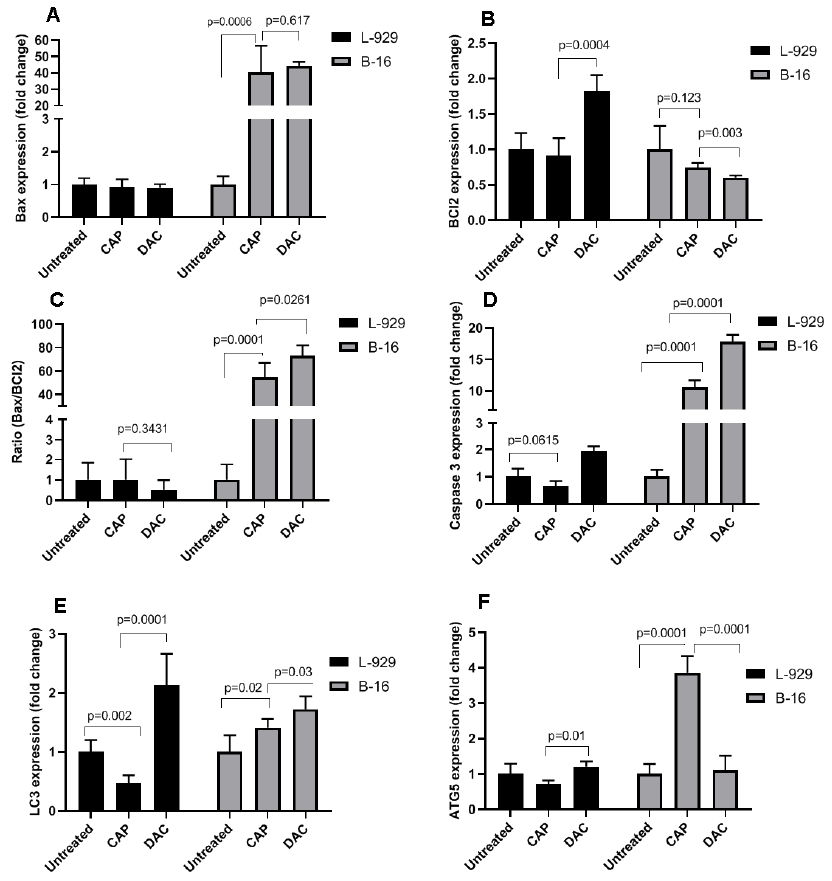
Figure 5. E ff ect of CAP on apoptotic gene expression in B16 tumor cells and non-malignant L929 cells. ( A – F ) 24 h after CAP or DAC treatment, mRNA was extracted, and the expression of apoptotic (Bax, ( A ); Bcl2, ( B ); caspase 3, ( C ); and Bax to Bcl2 ratio, ( D )) and autophagy-related (ATG5, ( E ); and LC3, ( F )) genes was evaluated using real-time PCR. In all experiments, GAPDH was considered as the housekeeping control gene. Altered gene expression is shown as fold changes referring to untreated control cells. The results are representative of three independent experiments and show mean +